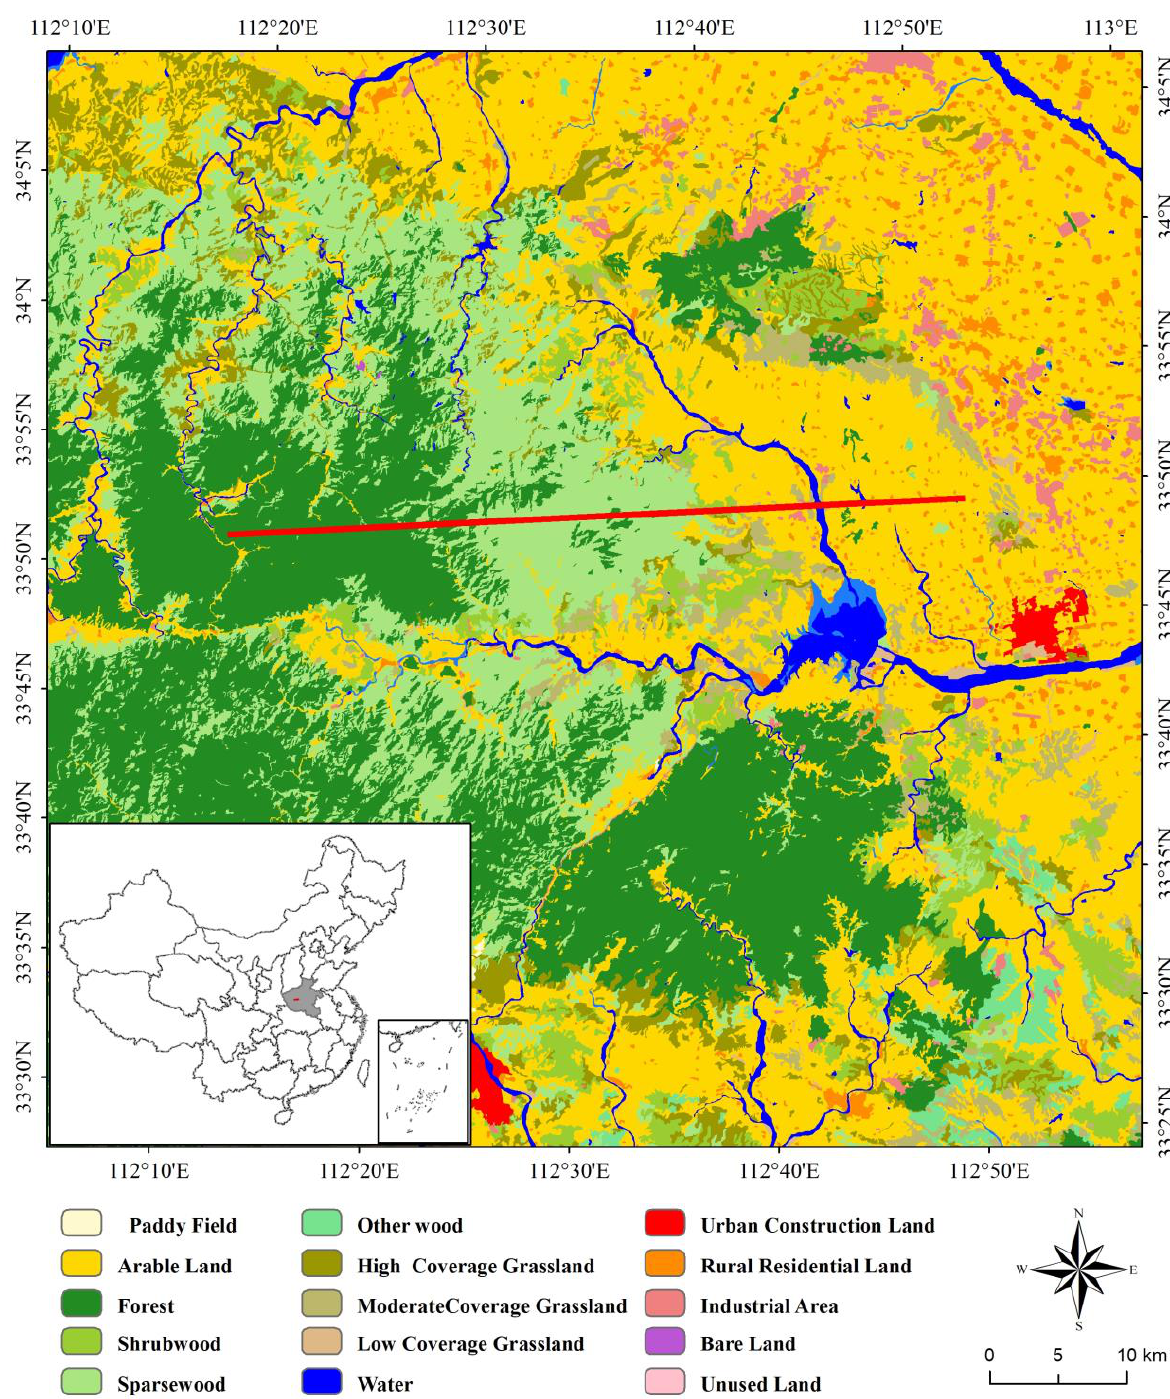
Figure 9. Profile position of the study area .